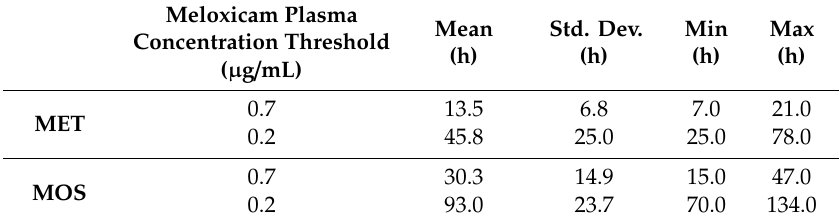
Table 6. Descriptive summary of time above blood thresholds of 0.2 and 0.7 µ g / mL for MET and MOS treatment